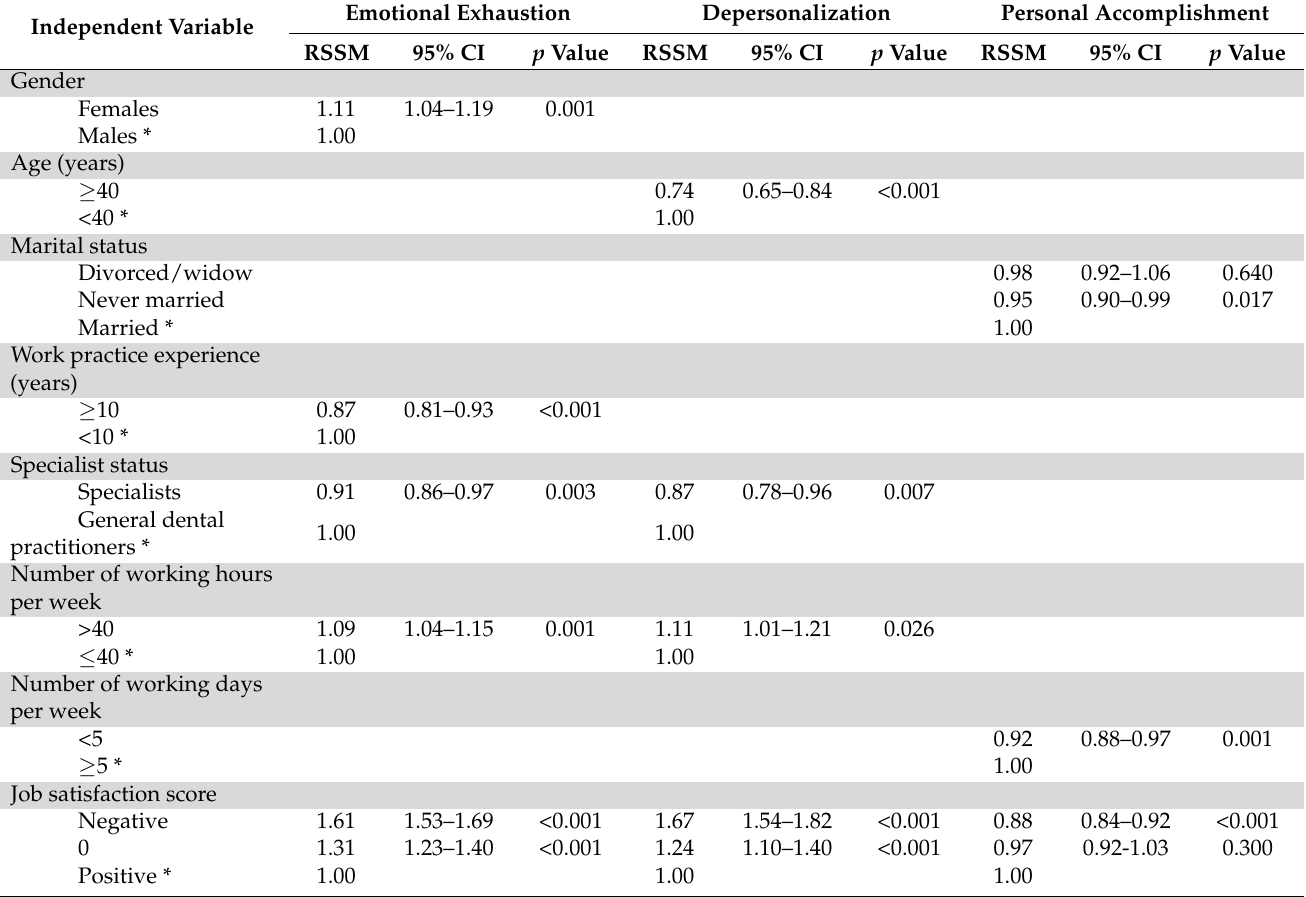
Table 5. Relationship between emotional exhaustion, depersonalization and personal accomplishment levels, and the significant independent variables: results from multivariate Poisson regression analysis a